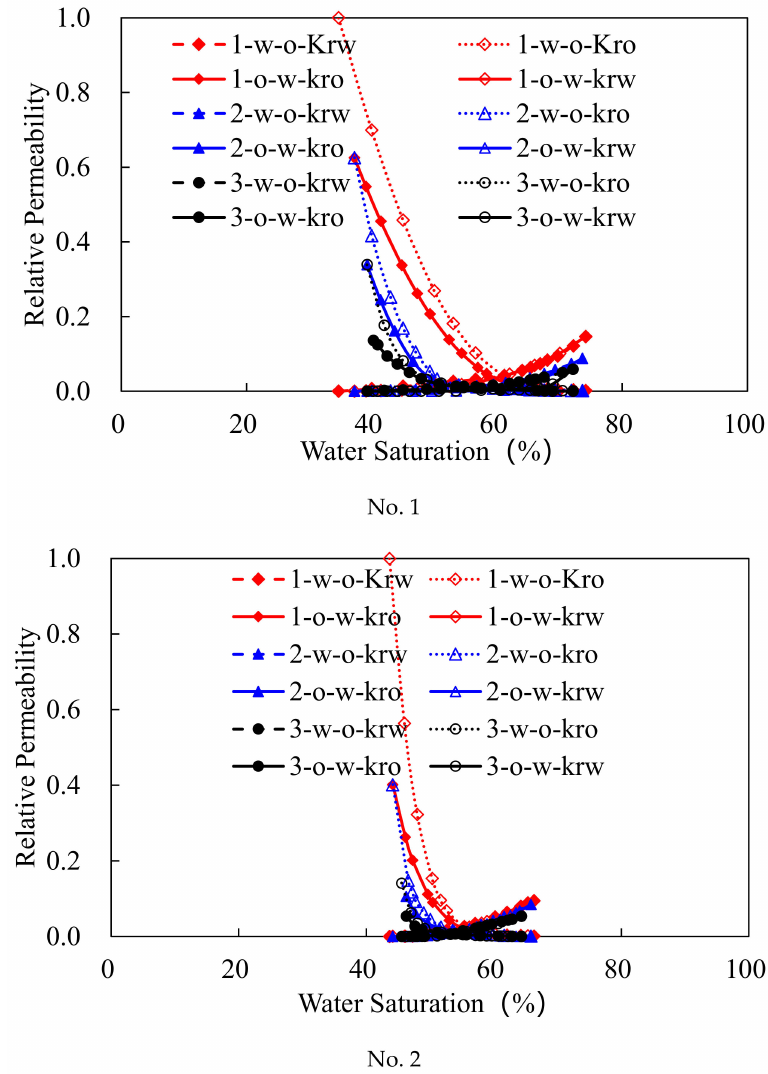
Figure 3. The characteristics of the multiwheel oil and water mutual flow seepage curve of cores 1 and 2. (1-g-o- K ro –1 represents turn; g-o represents gas flooding; K ro represents relative permeability of oil